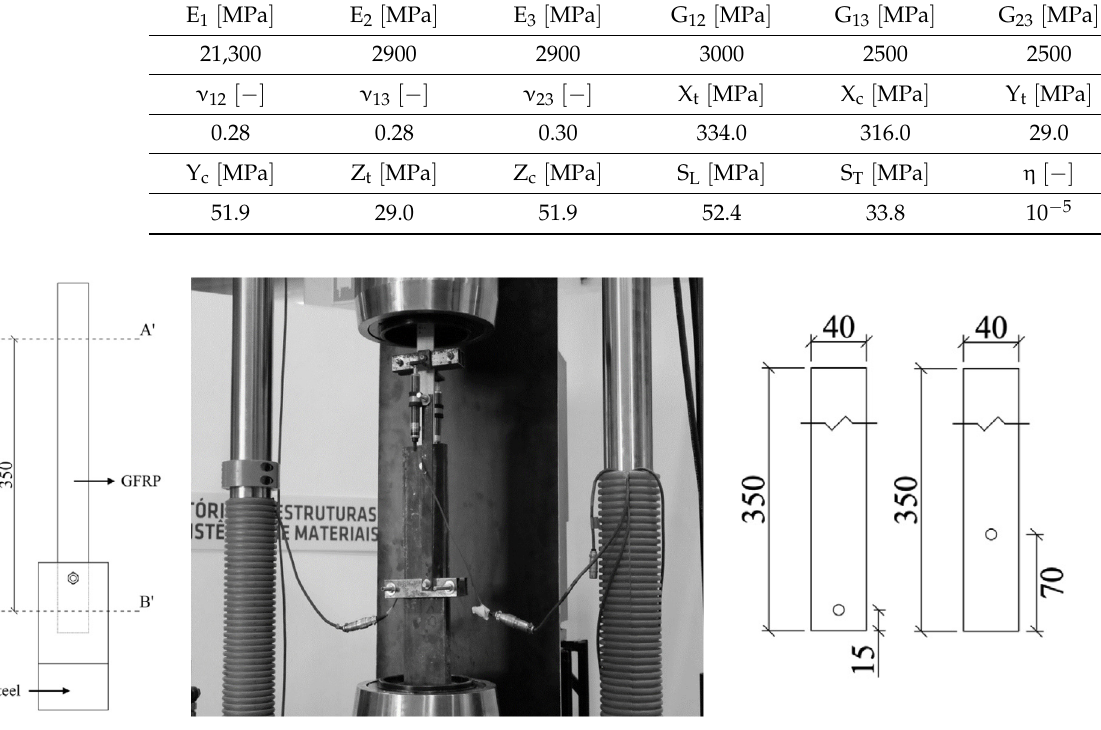
( d ) Figure 16. Adopted 3D mesh for 70 mm cover ( a ) and 15 mm cover ( b ) and symmetry conditions for 15 mm cover ( c ) and 70 mm cover ( d ) for the double-lap test.